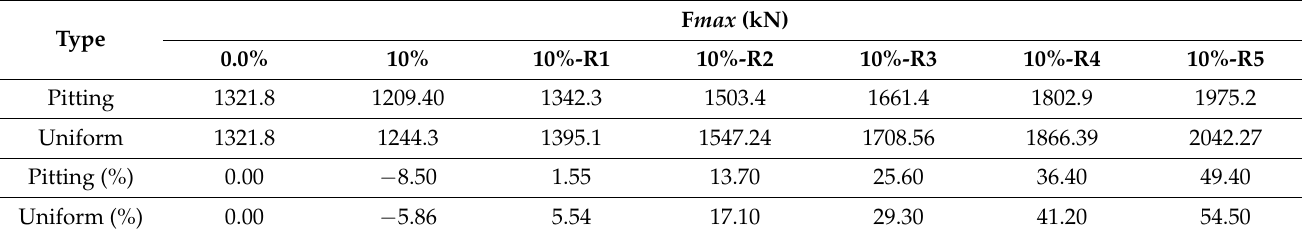
Table 3. Peak force of a bridge pier with 10% corrosion under different thicknesses of steel